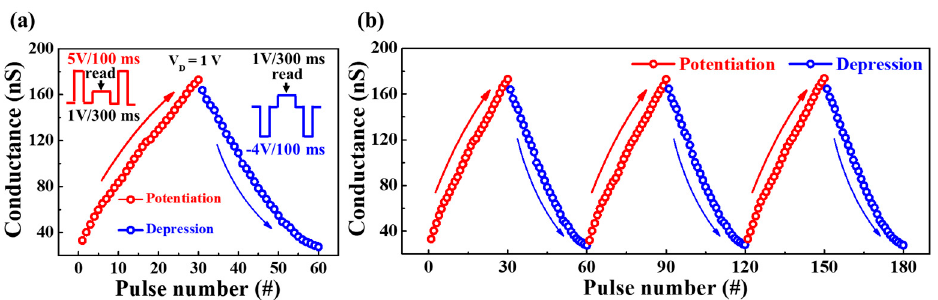
Figure 7. ( a ) Channel conductance modulation by application of 30 potentiation pulses and 30 de- pression pulses to the pre-synapse. ( b ) Endurance characteristics for three consecutive cycles of po- tentiation and depression.